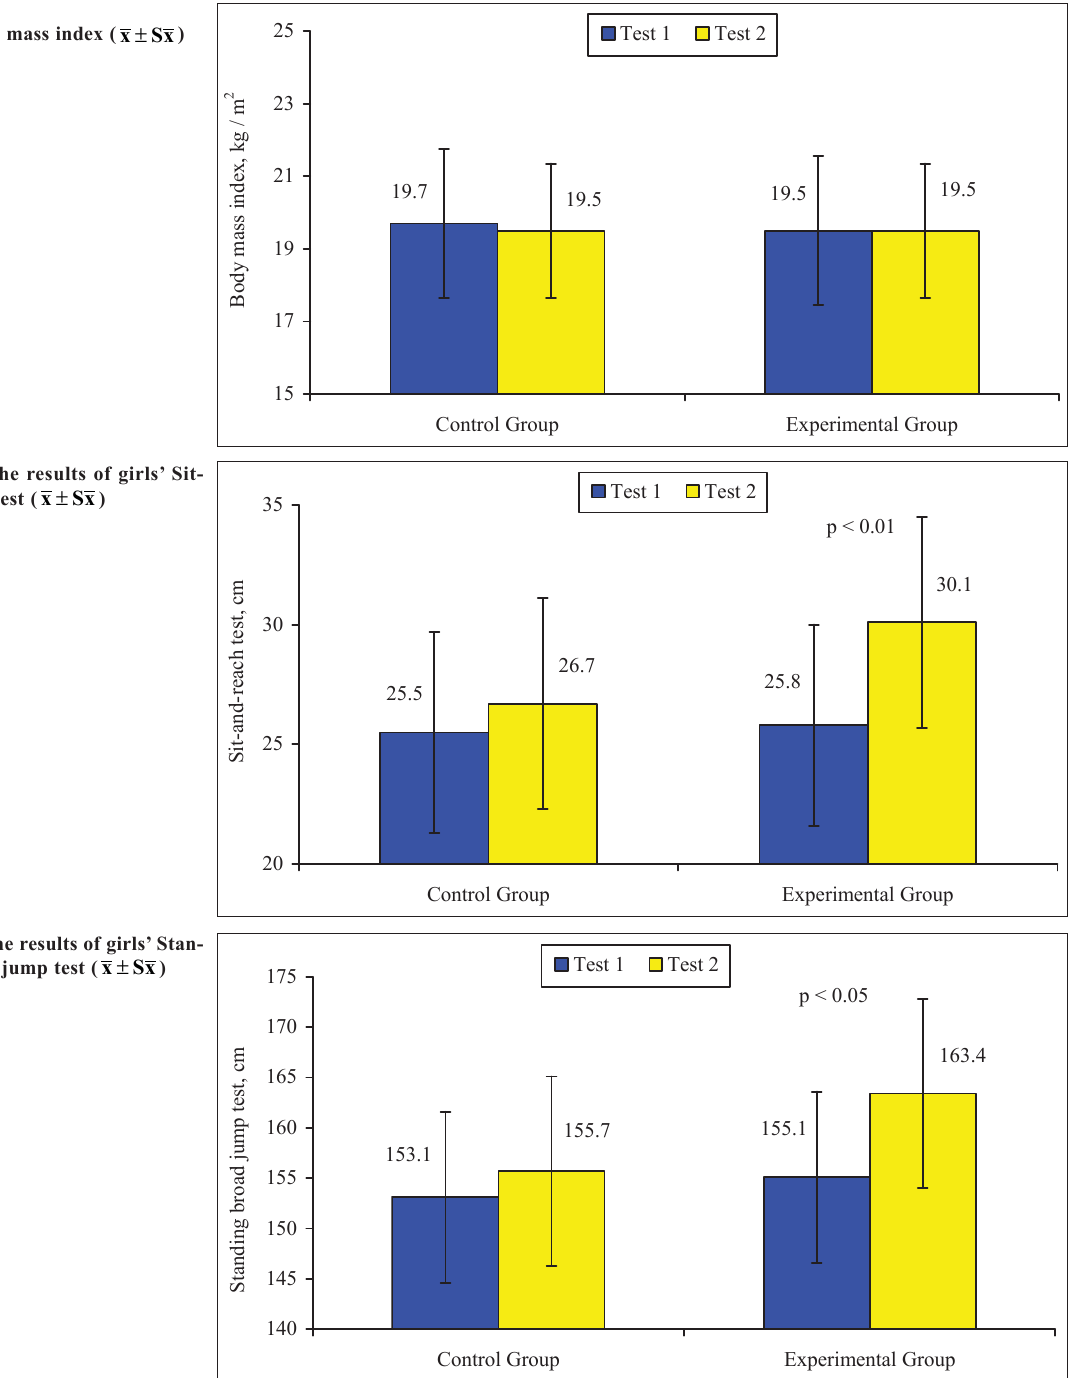
Figure 4. The results of girls’ Sit- and-reach test ( xSx ±